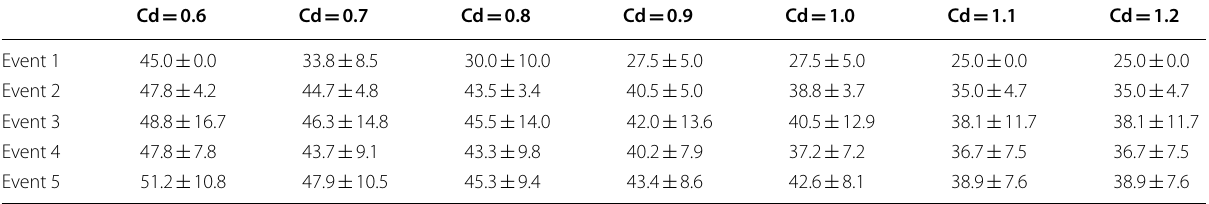
The values are shown as “mean standard deviation” in each cell. Mean values are also shown in Fig. 6 ±